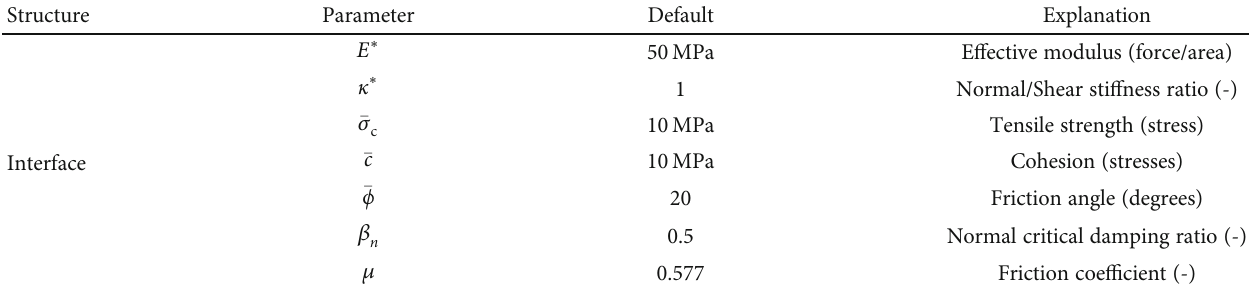
Table 3: Interface simulation